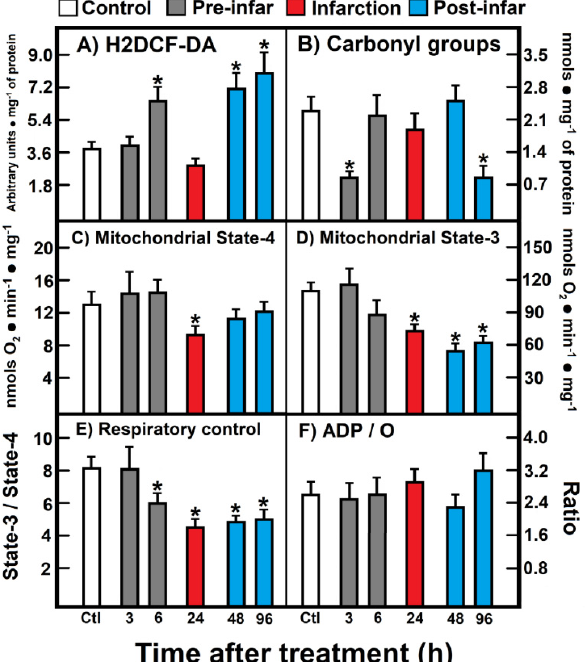
Figure 2. ( A )2 ′ ,7 ′ -Dichlorofluorescin diacetate (H2DCF-DA); ( B ) Carbonyl groups; ( C ) Mitochondrial State-4; ( D ) Mitochondrial State-3; ( E ) Respiratory control; ( F ) ADP/O. Parameters of oxidant stress and mitochondrial substrate oxidation. Results are expressed as mean ± S.E. of three control animals and five rats treated with ISO per experimental point. Symbols (colors) for the experimental groups at the top of the Figure. Statistical significance: * p < 0.05 against the control group.